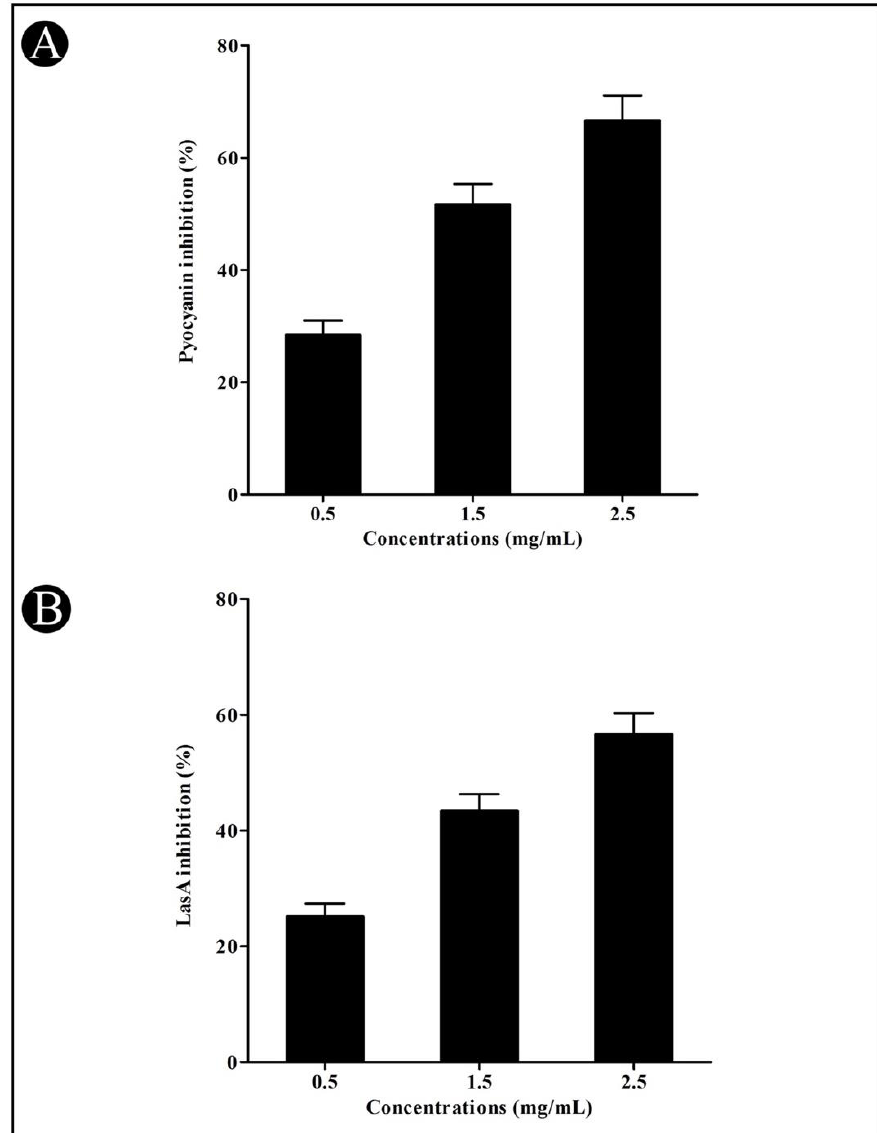
Figure 2. Inhibition of pyocyanin and LasA by the crude L. plantarum biosurfactant in P. aeruginosa at sub-MIC concentrations (0.5, 1.5, and 2.5 mg/mL). Pyocyanin ( A ) and LasA ( B ) were detected by a UV – VIS spectrophotometer and presented as percentage inhibition (with respect to untreated control). Values are represented as mean ± SD of three independent experiments.